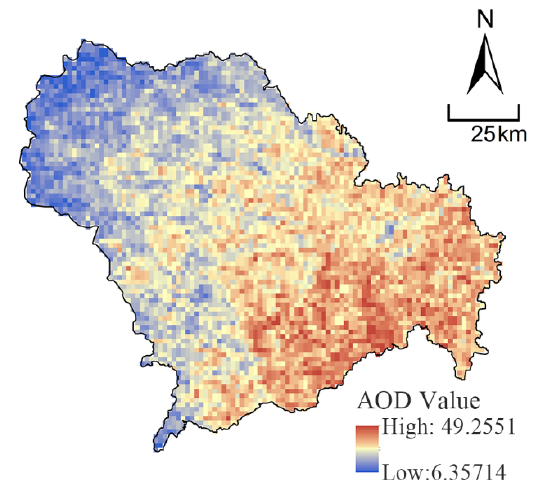
Figure 2. Spatial distribution of air pollution (AOD).